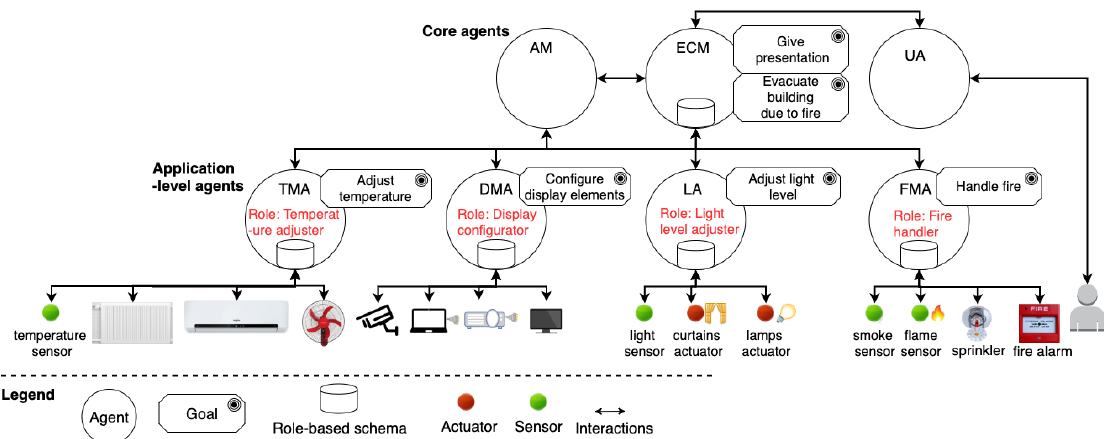
Figure 2. A snapshot of the runtime environment of the approach when realizing the smart meeting room